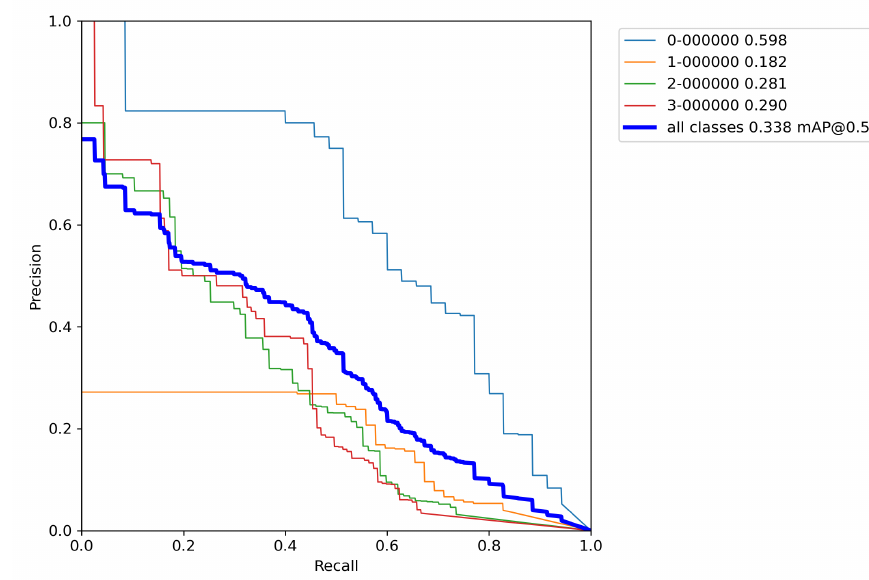
Figure A3. Base model P–R curve—Experiment